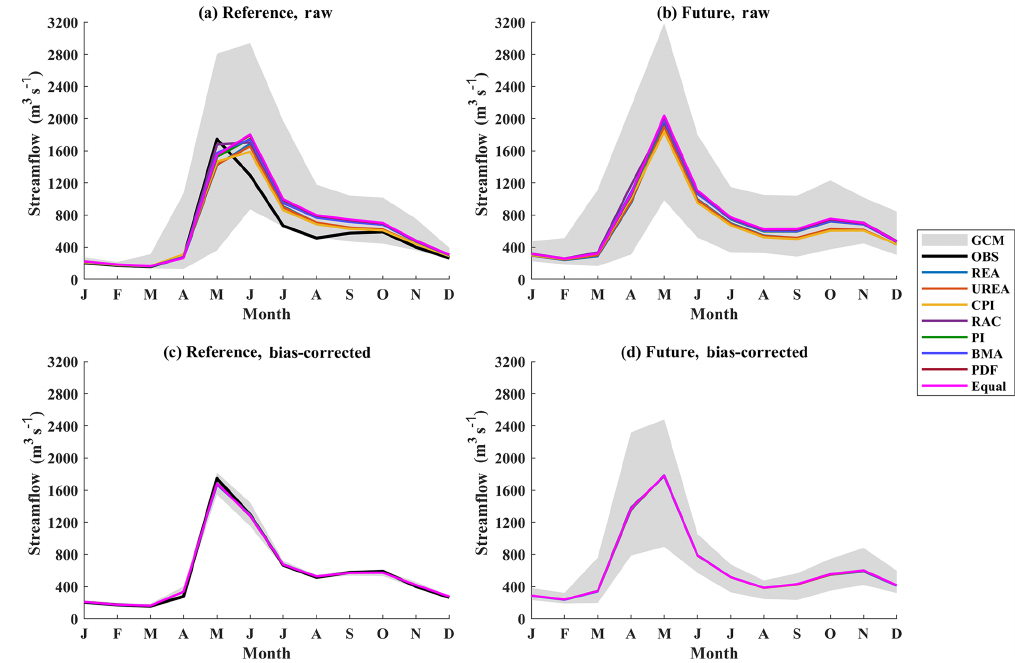
Figure 4. The same as Fig. 3 but for the Manicouagan-5